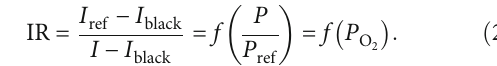
Figure 12: Film cooling e ff ectiveness distributions downstream of the branched holes, α